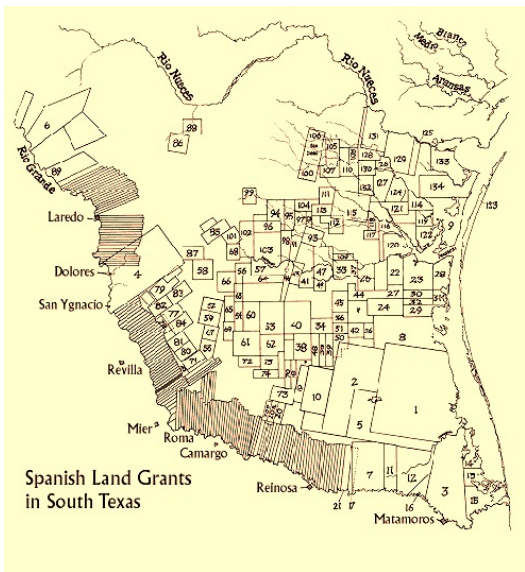
Figure 3. Spanish Land Grant Map (Jackson 1986).